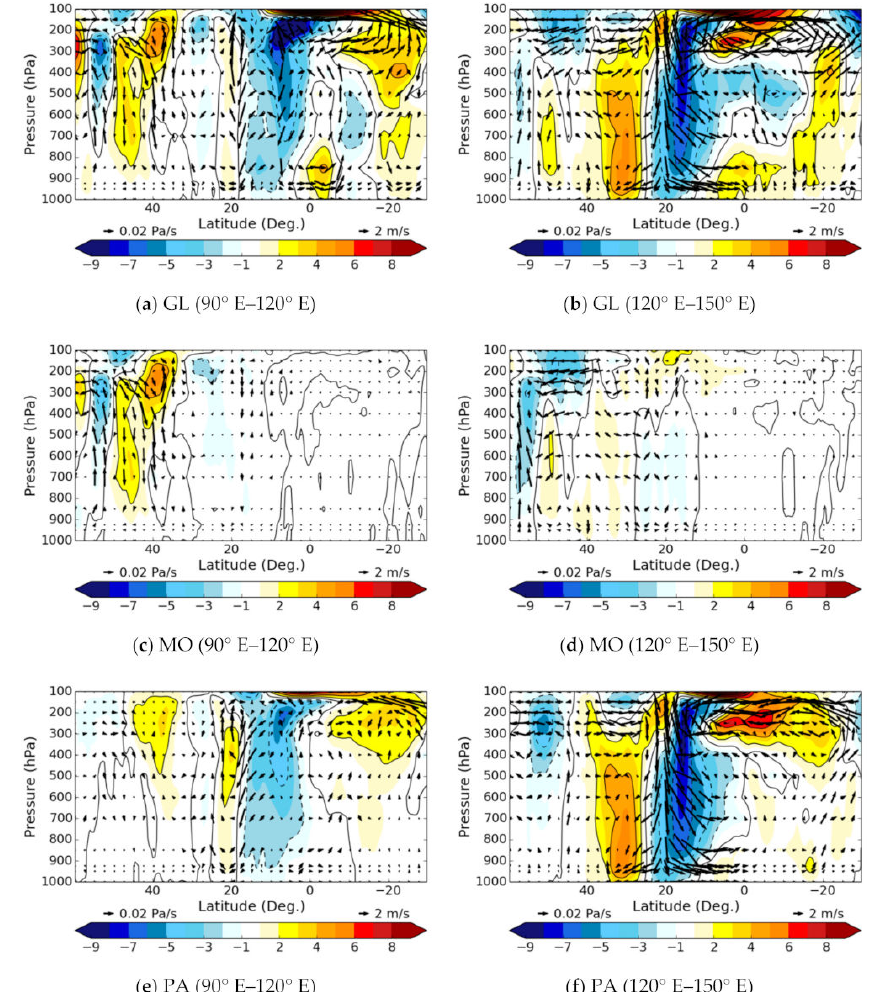
Figure 7. Di ff erences in 7-day forecasted fields of zonal U wind (contour and shading) and meridional-omega wind vector between each experiment (( a , b ) for GL, ( c , d ) for MO and ( e , f ) for PA) and the CTL experiment averaged during the heat wave period (11–25 August 2016). ( a , c , e ) are averaged between 90 ◦ E–120 ◦ E (same longitude with MO experiment) and ( b , d , f ) are averaged 120 ◦ E–150 ◦ E (same longitude with PA